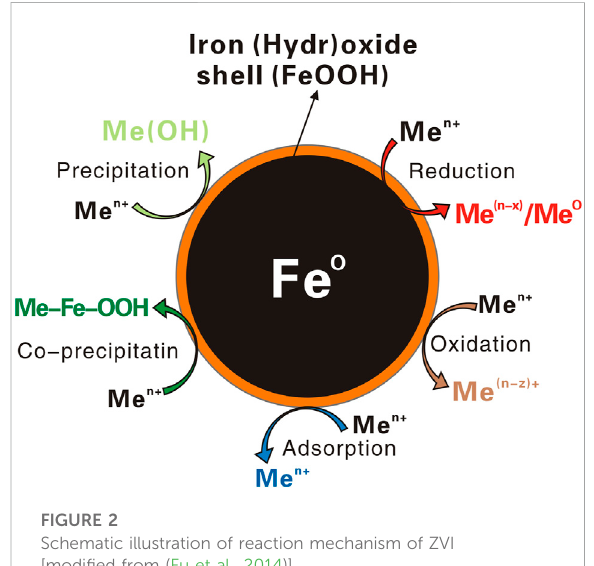
FIGURE 2 Schematic illustration of reaction mechanism of ZVI [modi fi ed from (Fu et al.,